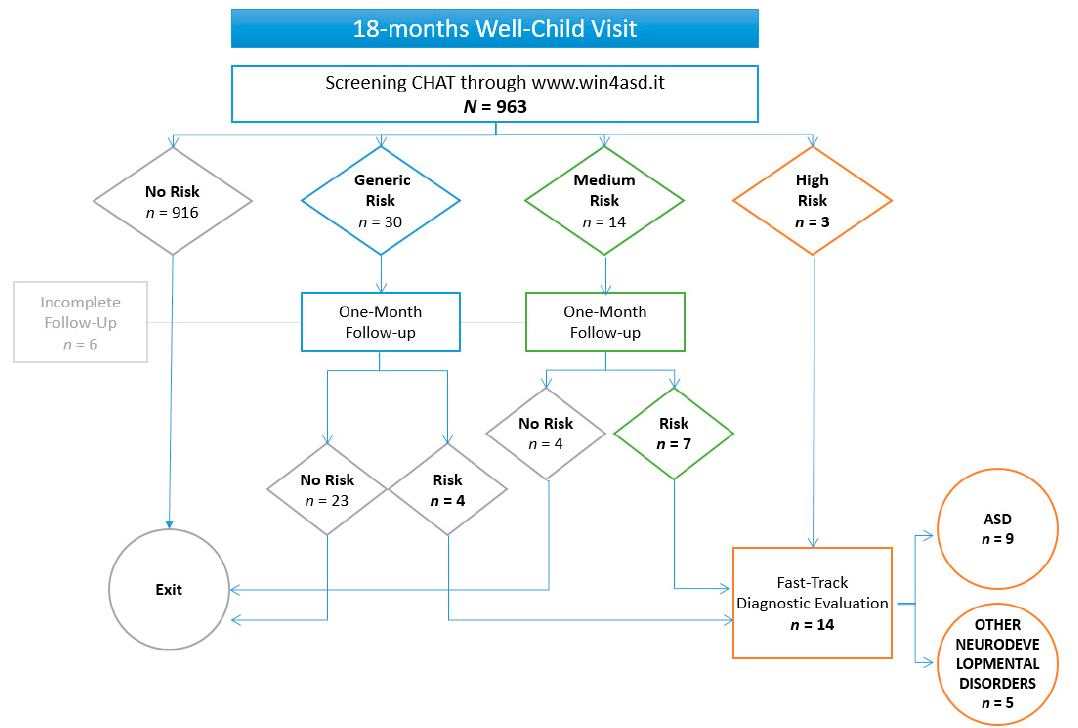
Figure 2. Flowchart showing screening results and diagnostic outcomes. Table 1. Performance measures of the WIN4ASD web app (* data on 2021 refers to January–